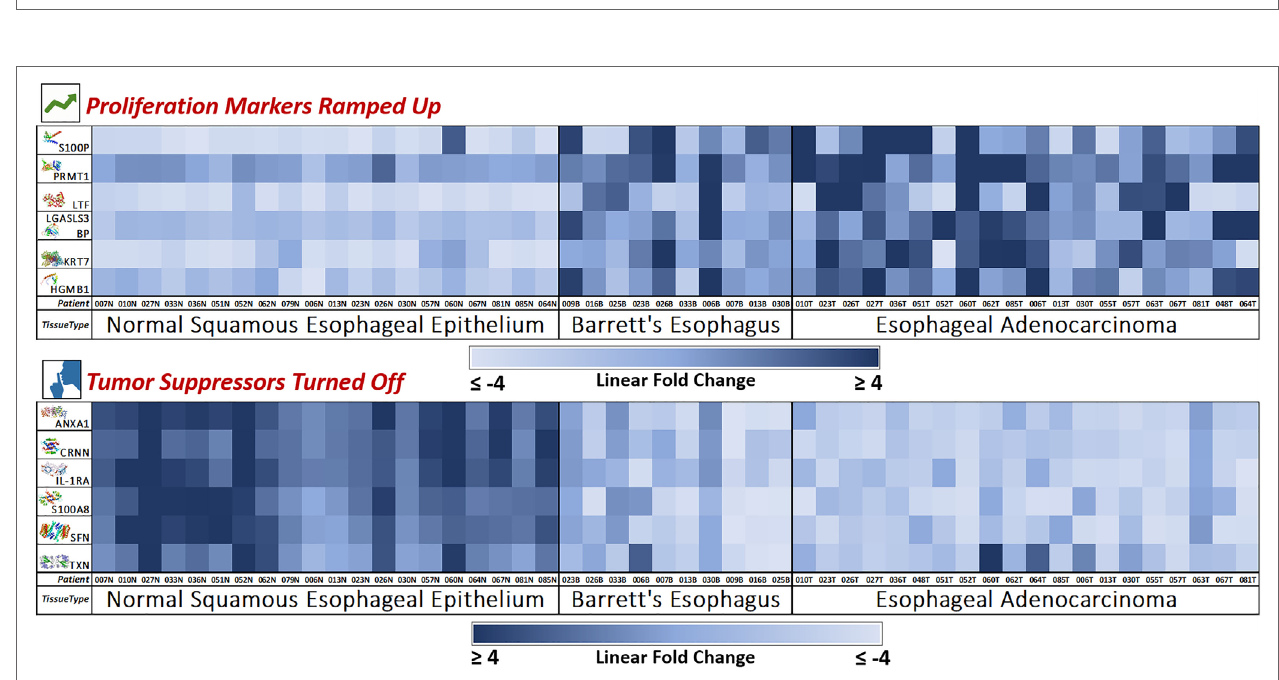
FIGURE 4 | Novel marker heat maps—proliferation up, tumor suppression down. Heat maps of the two groups of novel markers (cellular proliferation and tumor suppression) found to be upregulated or downregulated during esophageal pathogenesis (Normal → Barrett’s → Adenocarcinoma). This provides for an individualized bird’s eye view of the expression trends of our newly discovered 12 markers in 50 patient samples, showing consistent trends with very few outliers. Here, we see how the mass spectrometry platform can yield statistically significant biomarkers with consistent and reliable expression trends. Notably, Barrett’s tissue shows expression levels similar to adenocarcinoma, meaning that these protumoral expression trends manifest in the precancerous Barrett’s tissue and carries over throughout carcinogenesis.